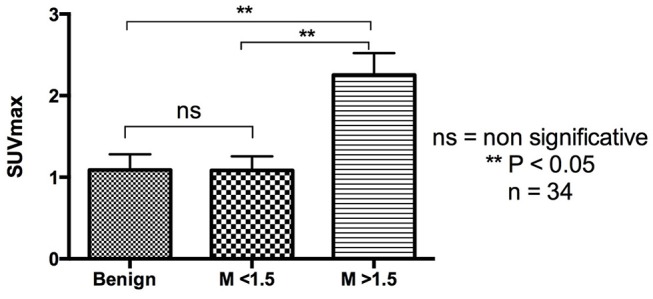
A minimum of 1.5 cm of tumor size is necessary to identify malignant mammary tumors according to their SUVmax. The graph shows results of an ordinary one-way ANOVA analysis for benign and malignant (M) lesions with a cut-off value of 1.5 cm.